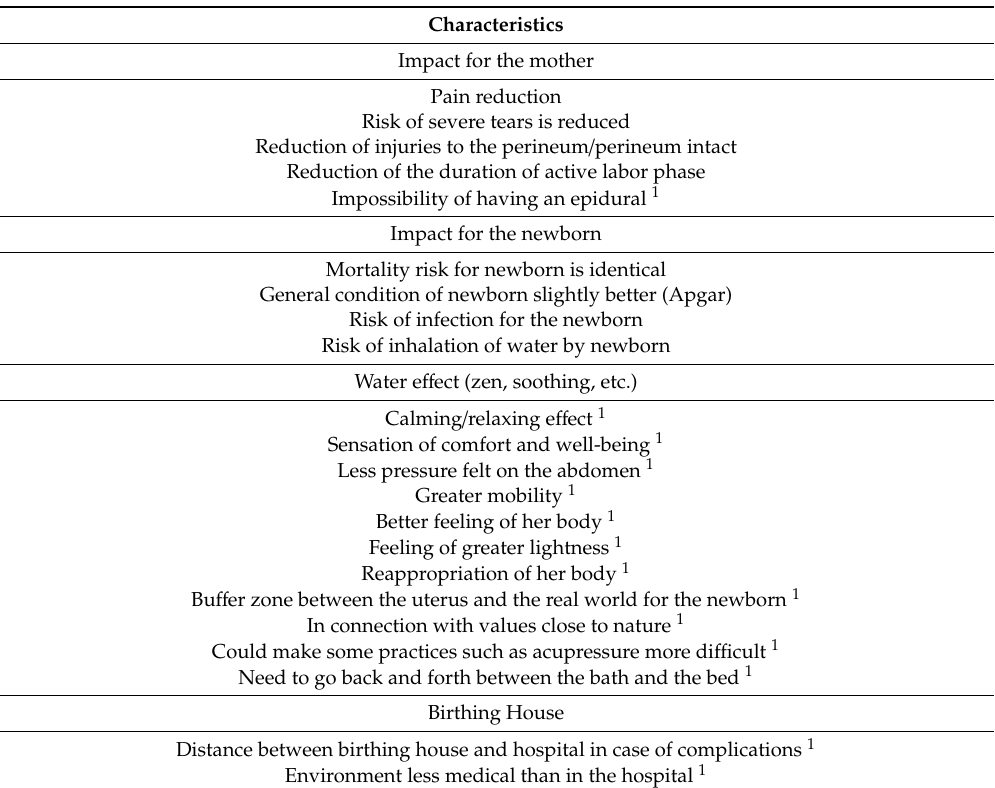
Table 1. List of characteristics identified during focus groups.